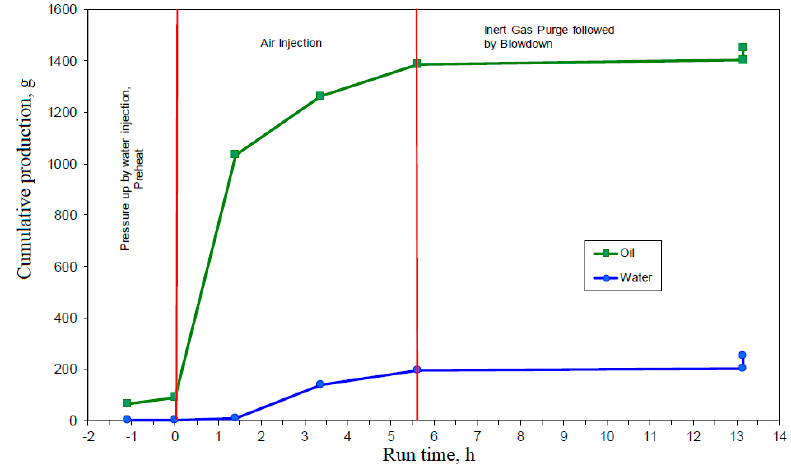
Figure 10. Reverse Combustion Oil and Water Production cumulative masses (Color should be used).